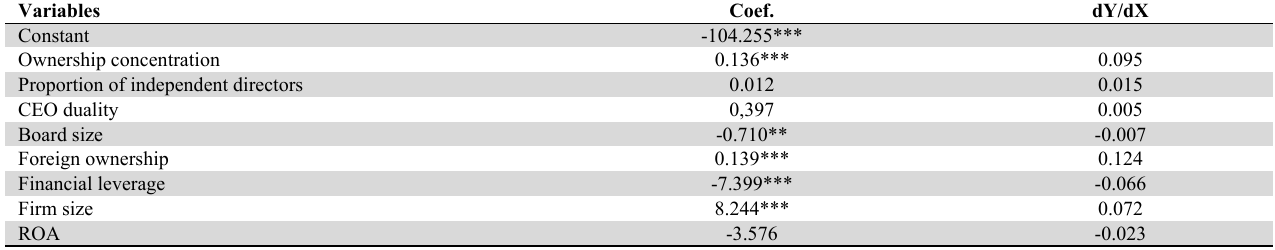
Logit REM regression results and marginal effects (dY/dX)